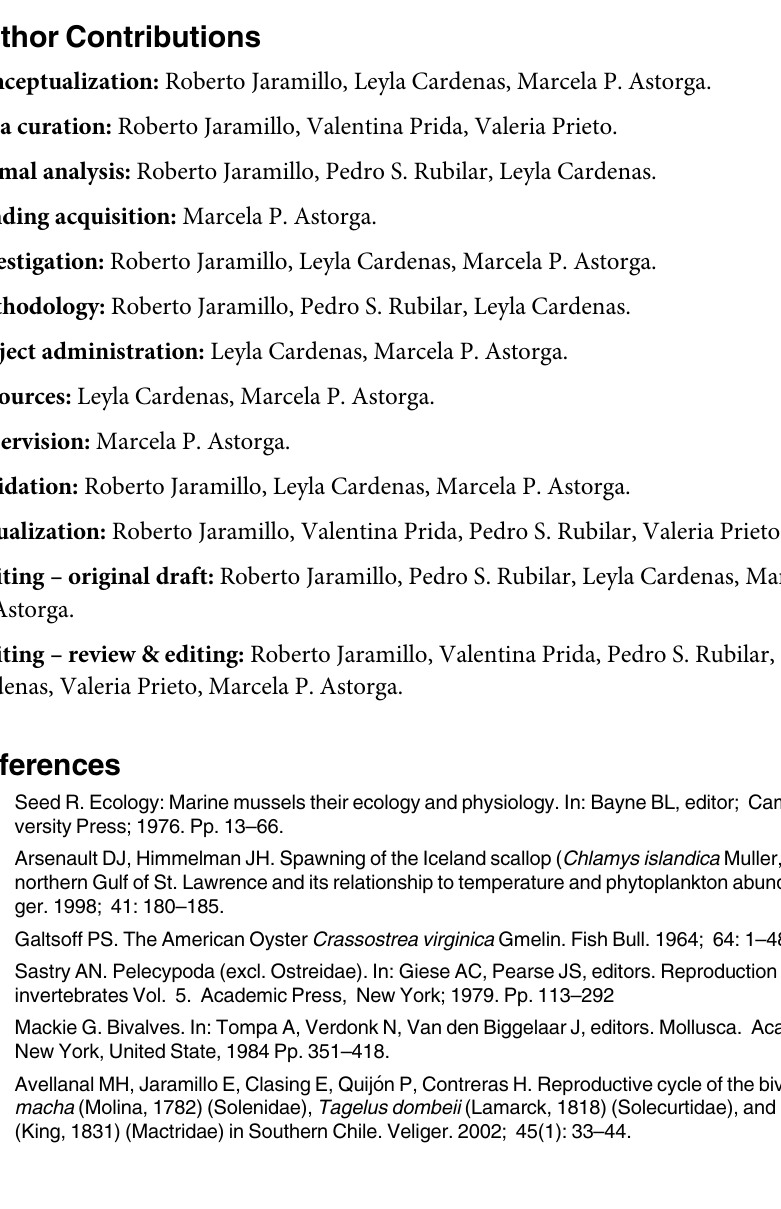
S1 Fig. Phylogenetic reconstruction by NJ based on the 18S gene for parasites collected from A . antiqua . Codes indicate accession numbers for samples obtained from the GenBank. Bootstraps are indicated on the nodes. (TIFF) S2 Fig. Phylogenetic reconstruction by ML based on the 28S gene for parasites collected from A . antiqua . Codes indicate accession numbers for samples obtained from the GenBank. Bootstraps are indicated on the nodes.